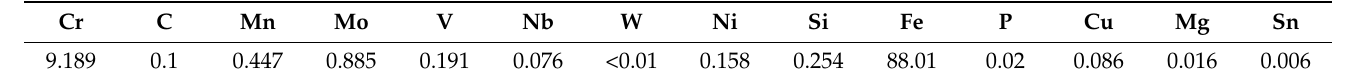
Table 1. Chemical elements (wt %) of the P91 steels.